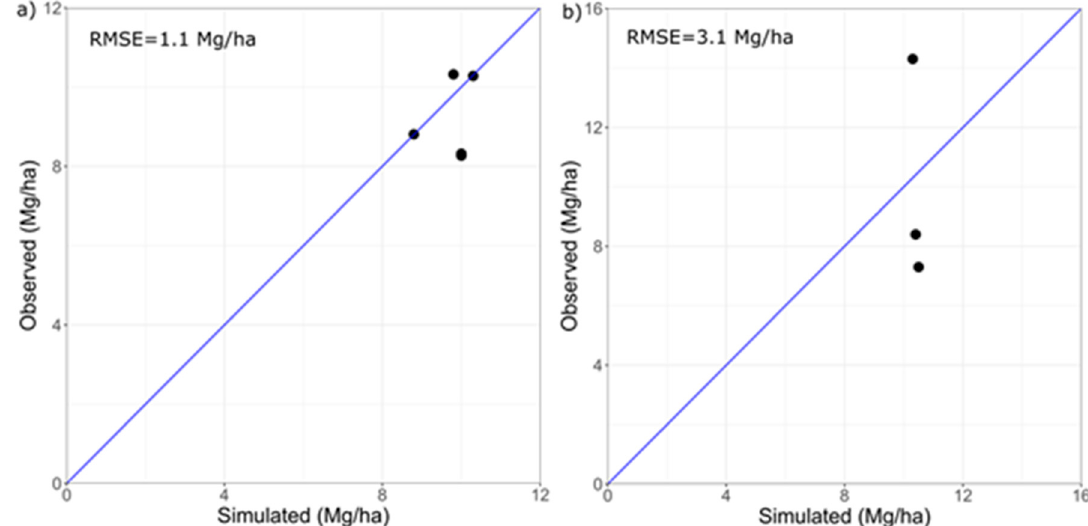
Figure 1. Observed and simulated Leaf Area Index (m 2 /m 2 ) at two experimental sites Akukayili (upper row) and Cheshegu (lower row) in Ghana under fertilized and control conditions.